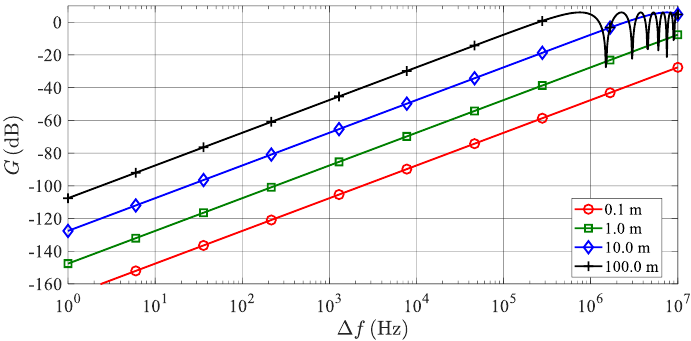
Figure 6. Transfer function of phase noise in TS and various target ranges. The function is plotted in the logarithmic frequency scale and positive values of Δ f .